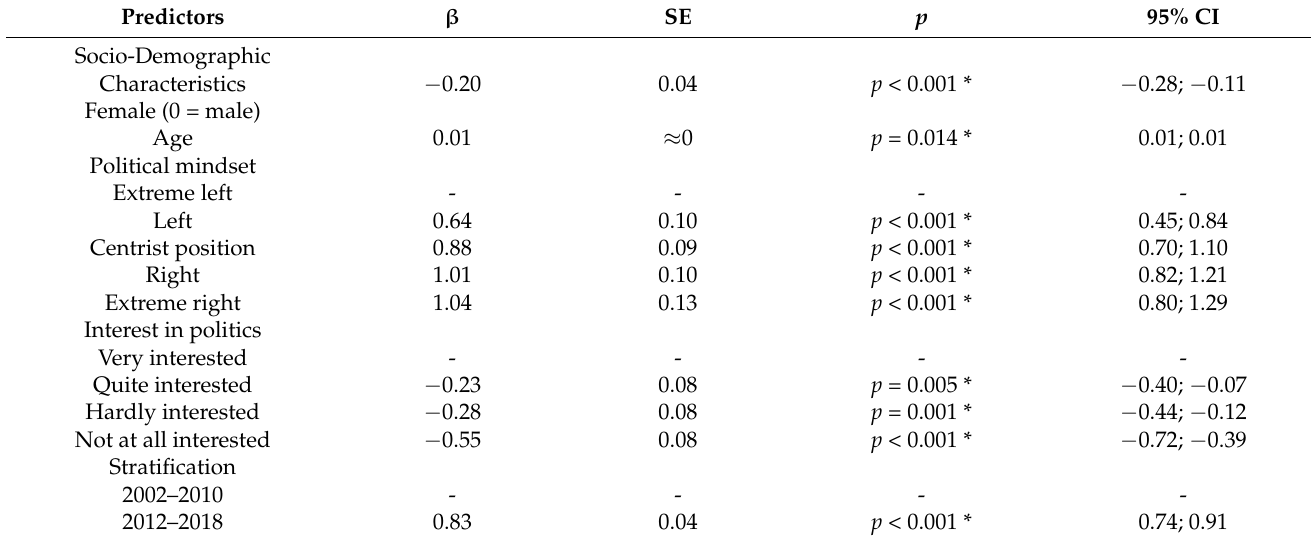
Table 6. Model 3—ideological preferences adjusted for stratification